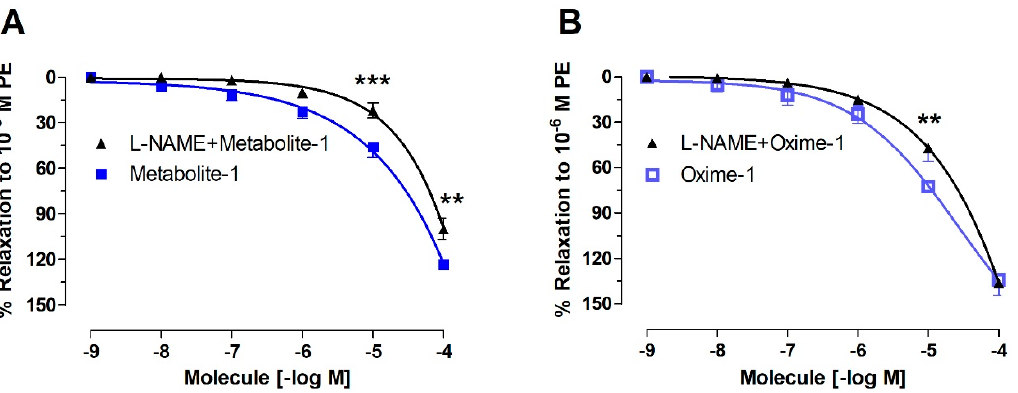
Figure 5. Metabolite- and oxime- caused relaxation in rat aorta depends on the nitric oxide pathway ( A , B ). Intact aortic rings were pre-incubated with 10 − 4 M L-NAME for 20 min. Subsequently, aortic rings were pre-contracted with 10 − 6 M PE, and cumulative concentrations of molecules (from 10 − 9 to 10 − 4 M) were added in bath. Data are presented as the average standard error of the mean (SEM) of 4–5 independent experiments. ** p < 0.01; *** p < 0.001.